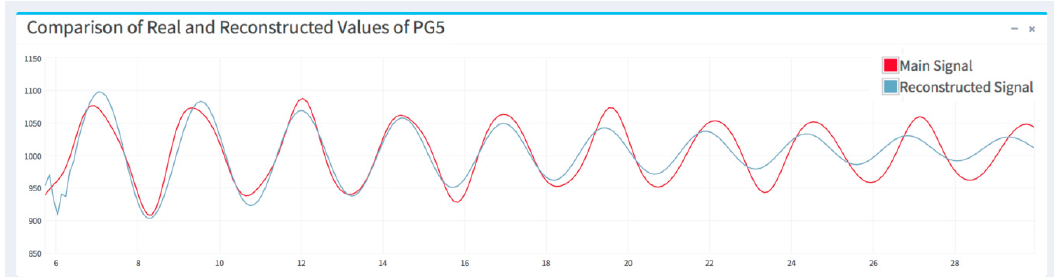
Figure 12. Comparison of real and reconstructed values of PG5 in Test Case 3.